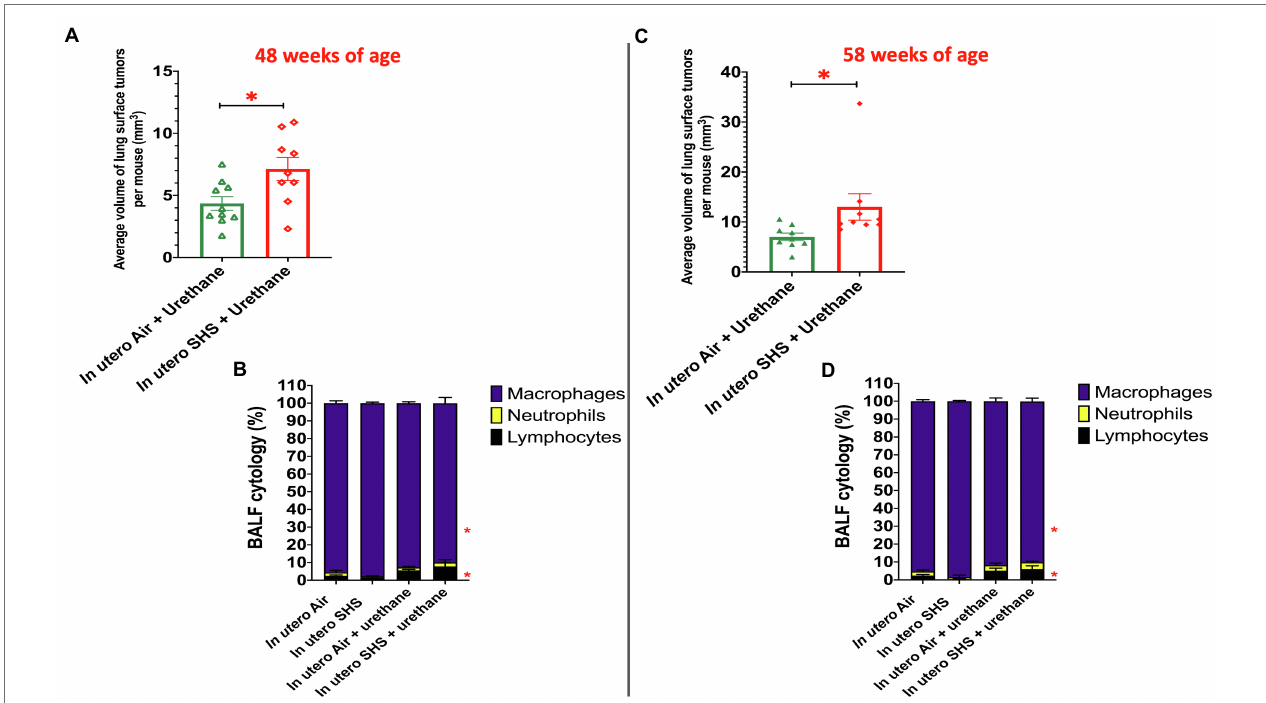
FIGURE 9 | In utero SHS plus adult urethane increased the volume of tumors as well as BALF inflammation. (A,C) Average volume of lung surface tumors in 48- and 58-week-old female mouse offspring, respectively, treated with urethane as adult. Tumors were estimated to be either spherical or non-spherical. For spherical tumors: volume = 4/3 π r 3 ; and for non-spherical tumors: volume = 0.52 ab 2 (a = largest and b = smaller diameter). N = 9–10 per group, data are expressed as mean ± SEM. Student t -test, * p < 0.05: statistically different from in utero air plus urethane group. (B,D) Cytology analysis showing the percentage of leukocytes recovered from BALF of female mouse offspring at 48 and 58 weeks of age, respectively. N = 9–10 per group; data are expressed as mean ± SEM. ANOVA followed by Tukey’s test for multiple comparisons, lymphocytes, and macrophages: * p < 0.05: statistically different from in utero air plus saline